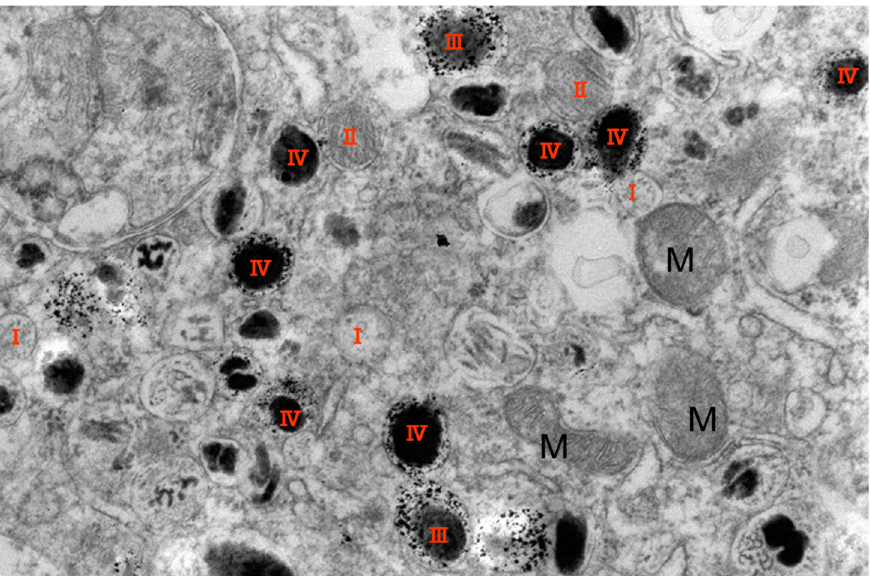
Figure 5. Transmission electron microscope observation. Electron microscopic observation of magnetite nanoparticles in the NPrCAP/M-treated melanoma cells after ip administration to a melanoma-bearing mouse. NPrCAP/M nanoparticles were highly accumulated in the late-stage melanosomes. M: mitochondrion, I-IV: stage of melanosome. Adapted from [45].